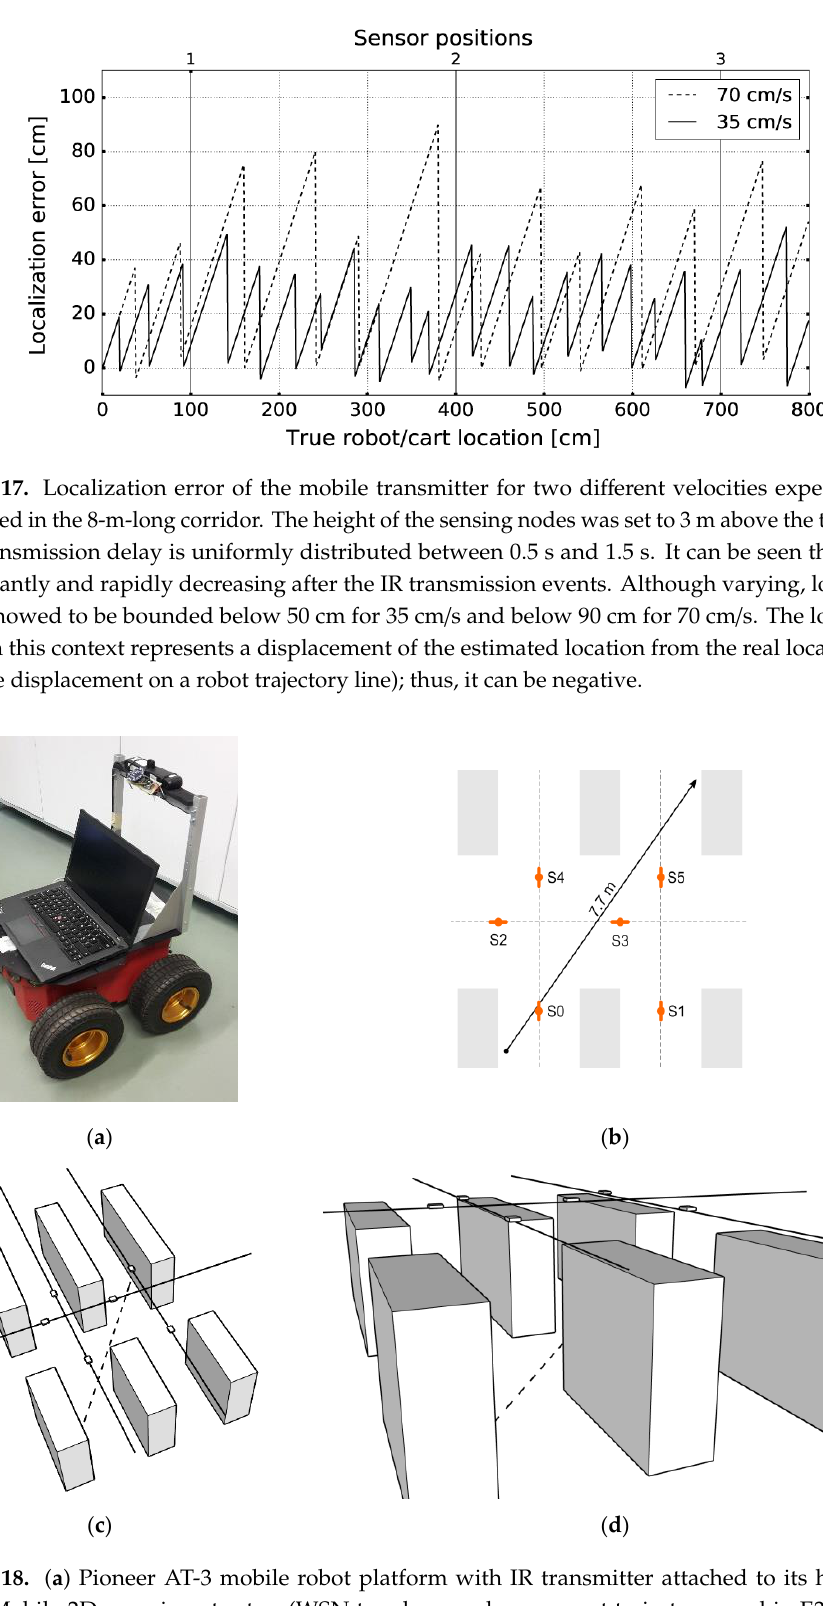
23 of 32 Figure 16. Localization error experimentally measured in the 8-m-long corridor for every 10 cm. Distribution of nodes with IR AoA sensor d was one in every 2 and every 3 m, left and right column, respectively. The height of the sensing nodes above the IR transmitter h was set to 2 and 3 m, top and bottom row, respectively. As can be seen from the presented results, in all scenarios, localization error did not exceed 10 cm. According to the obtained results, we can reasonably recommend WSN density with 2–3 m sensor spacing, as well as sensor placement onto the lighting infrastructure. It is assumed that supermarket lights are placed above the aisles, 2–3 m above the IR transmitter level, which is typically a case in order to evenly illuminate all shelves. In the described experiment E1 all measurements were performed with the static IR transmitter. However, in the real-world scenario, the transmitter is mobile and, due to the described transmission delay, the real-time localization error depends on movement speed. To evaluate the localization error of the mobile transmitter we performed the second experiment (E2).